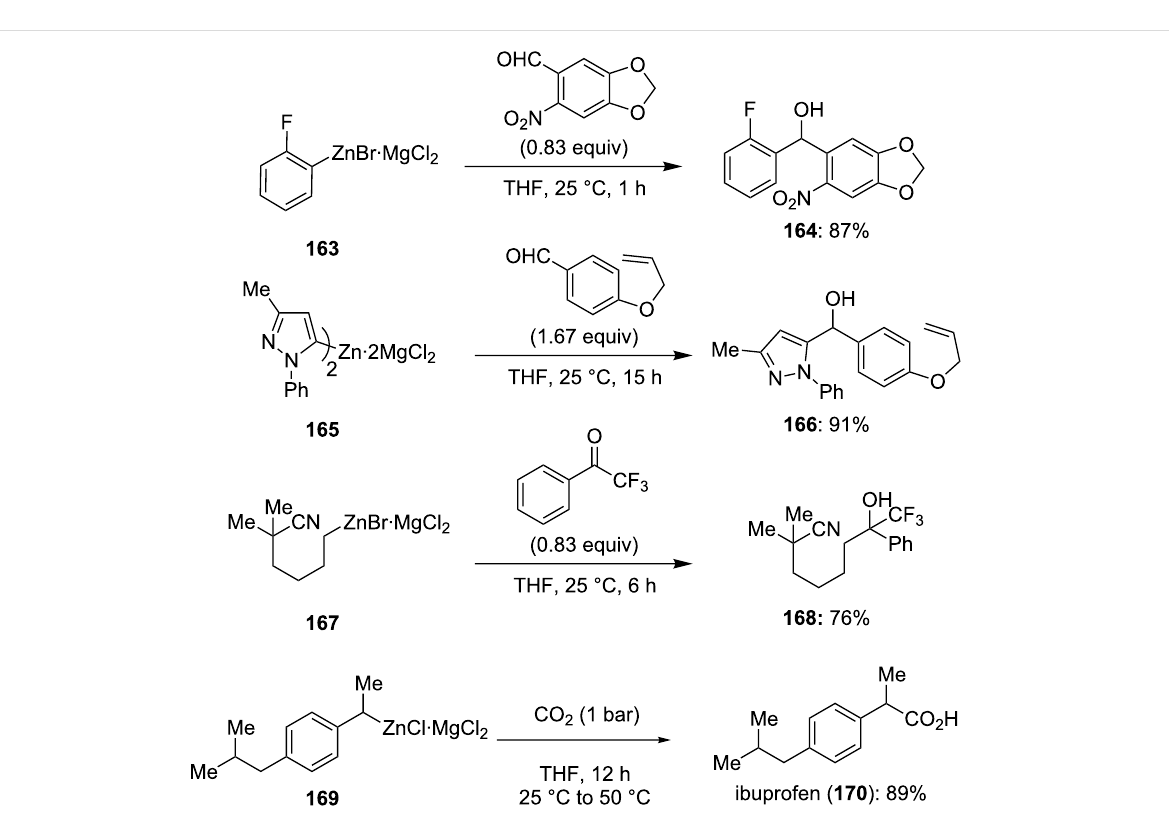
Scheme 25: MgCl 2 -mediated addition of functionalized aromatic, heteroaromatic, alkyl and benzylic organozincs to aldehydes, ketones and carbon